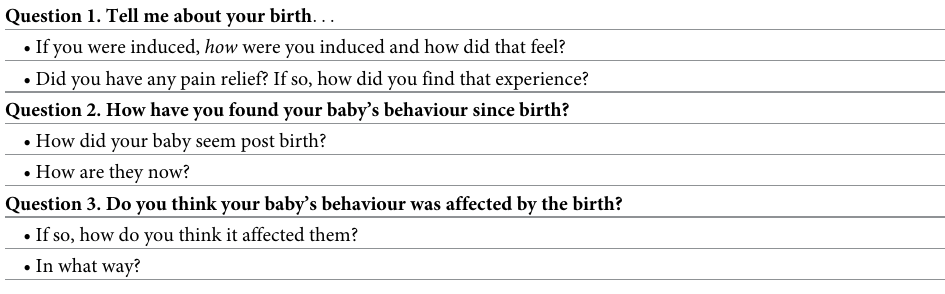
Table 1. Semi-structured interview schedule for mothers with example prompts. Question 1. Tell me about your birth